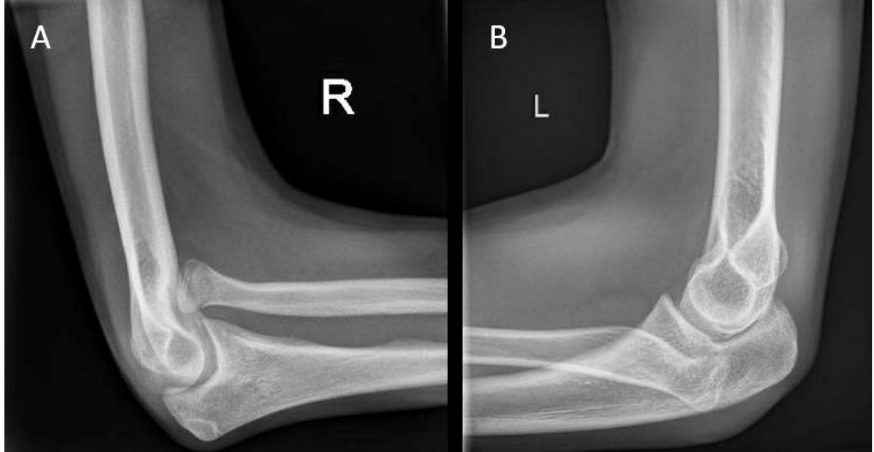
Figure 5. ( A ) A 17-year-old boy with congenital anterior radial head dislocations of the right arm. ( B ) A 16-year-old girl with congenital posterior radial head dislocations of the left arm, accompanied by a symptomatic elbow contracture. The girl was treated conservatively with a static progressive elbow flexion